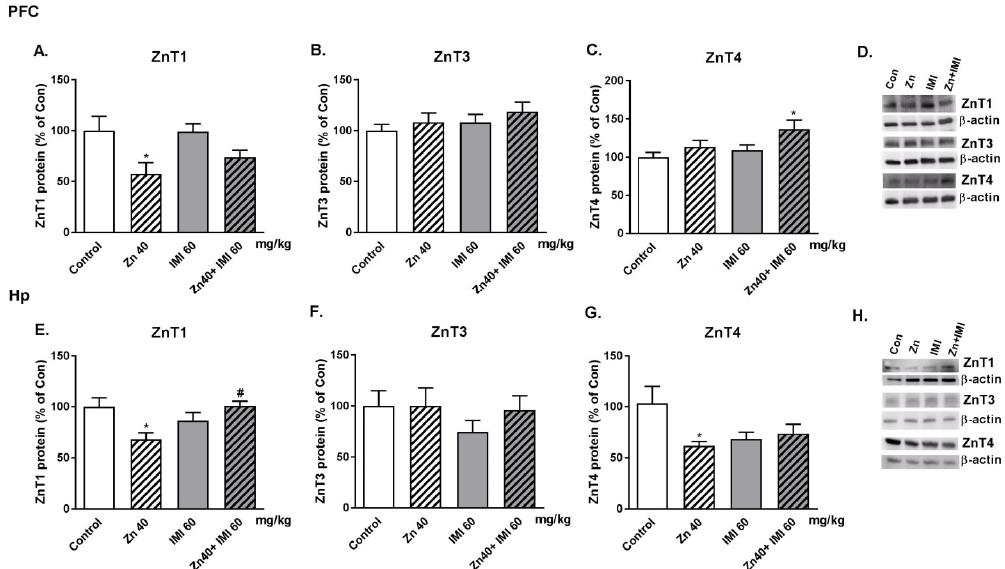
Figure 7. Western blot analysis of the effect of Zn (40 mg Zn/kg) + IMI (60 mg/kg), and NaCl (control) administered p.o. on the protein levels of Zn transporters: ( A , E ) ZnT1, ( B , F ) ZnT3, and ( C , G ) ZnT4 in the PFC and Hp of mouse brain. Representative western blots ( D , H ). Results are expressed as mean ± S.E.M (n = 5–6 per group). * p < 0.05 vs. control group, # p < 0.05 vs. Zn group (two-way ANOVA